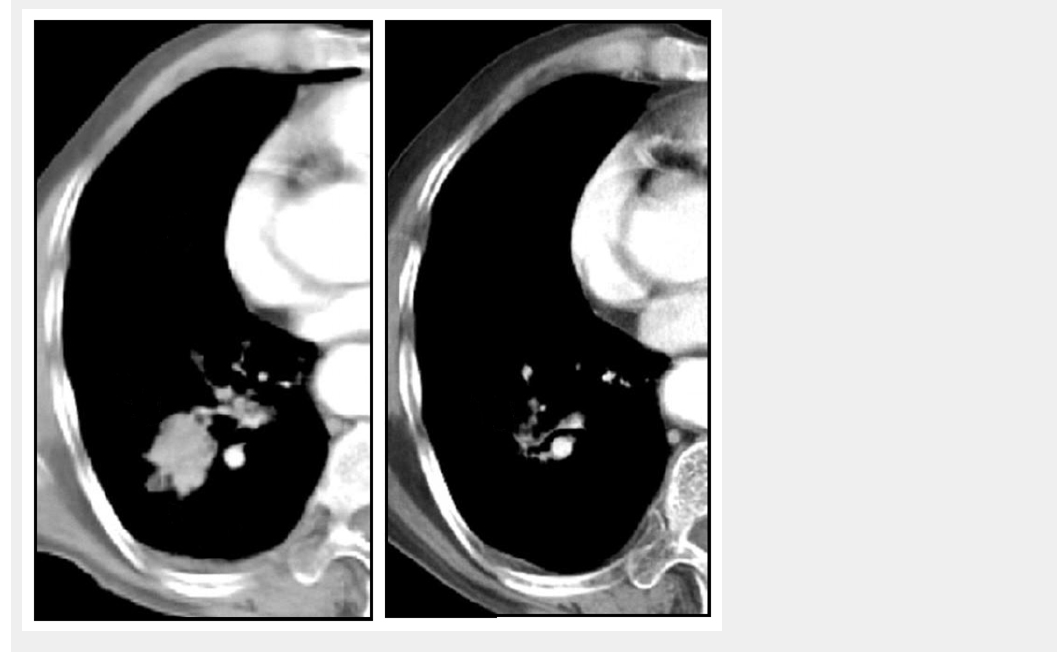
Figure 5 Chest CT of a patient treated with RFA- before and after